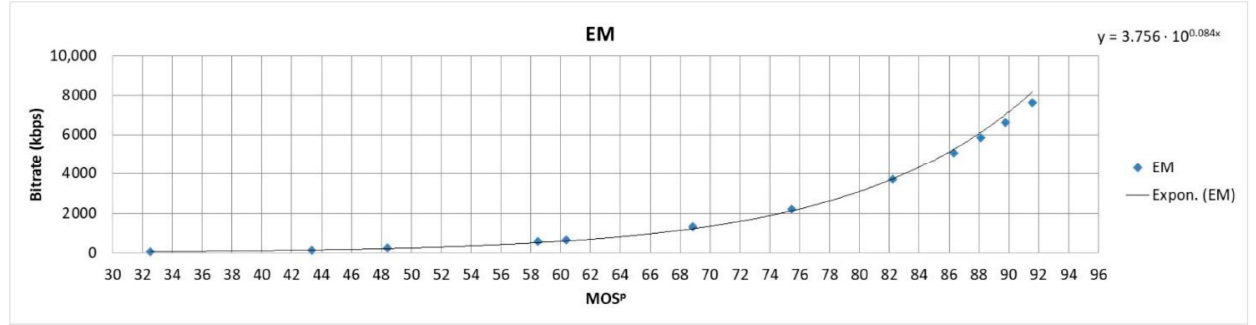
Figure 10. Bitrate- MOS p curves for EM video sequence. Table 6. Values of C 1 and C 2 coefficients used to describe the functional relationship between the bitrate and MOS p values for every video sequence used in the modeling process, as well as for BBB. Video